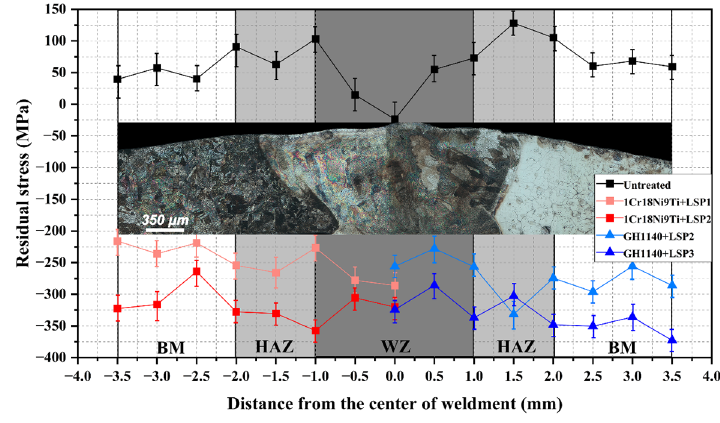
Figure 3. Residual stress distribution on weld surface of combustion liner.